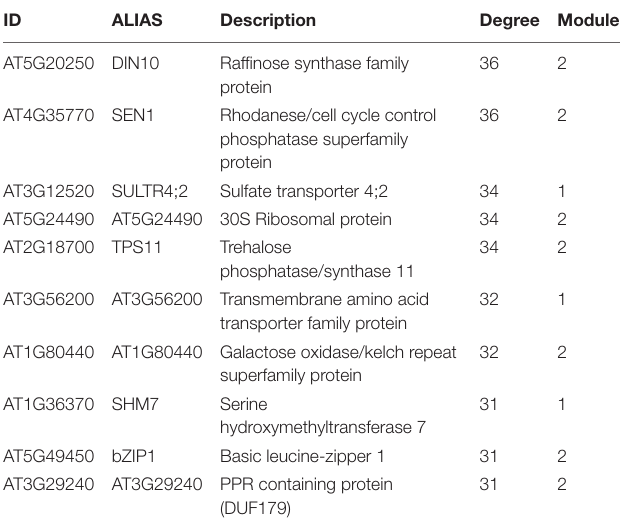
TABLE 3 | Ranking of the 10 most connected genes in the sulfate co-expression network. ID ALIAS